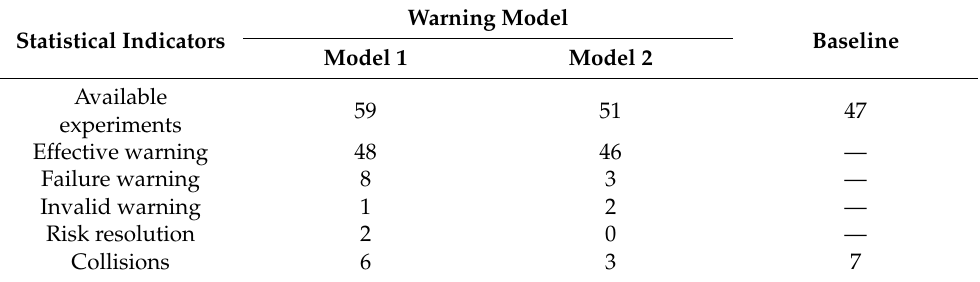
Table 3. Statistical values of warning effects.